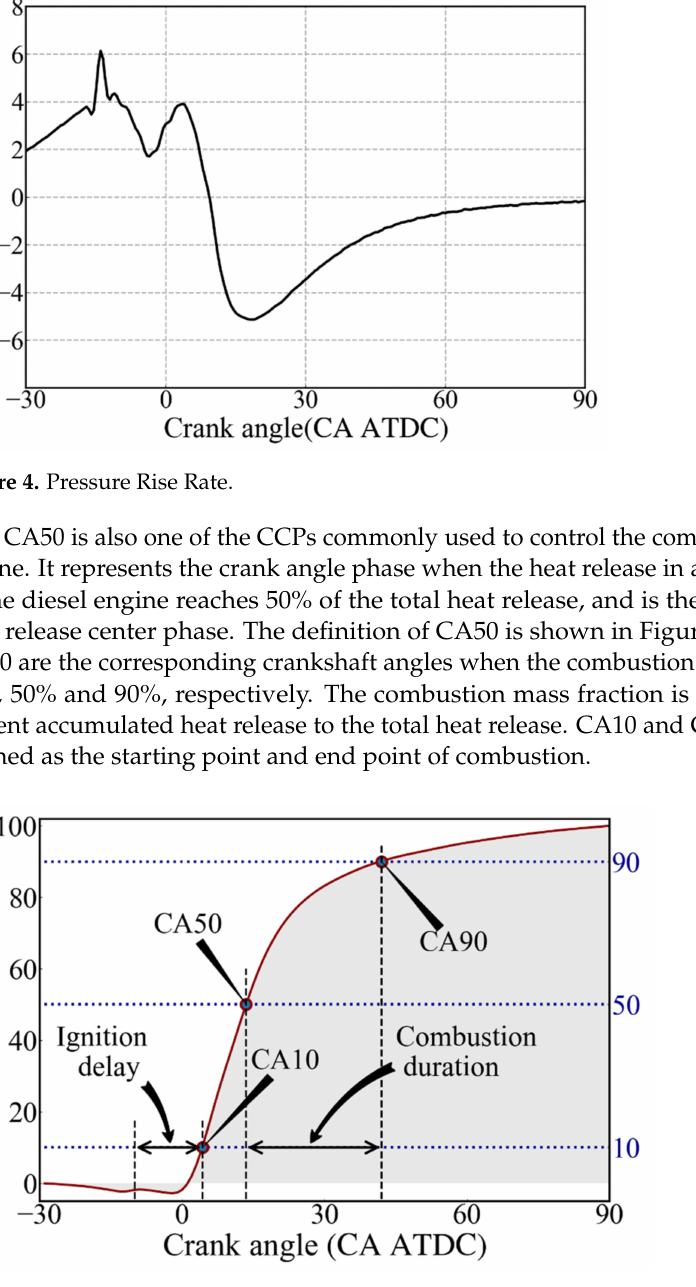
Figure 5. Important phases in combustion